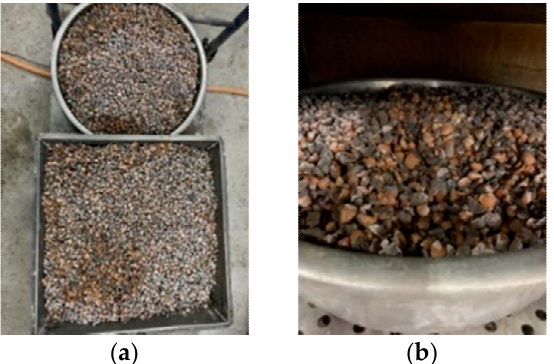
Figure 4. Draining and drying of lightweight aggregates: ( a ) draining; ( b ) drying.